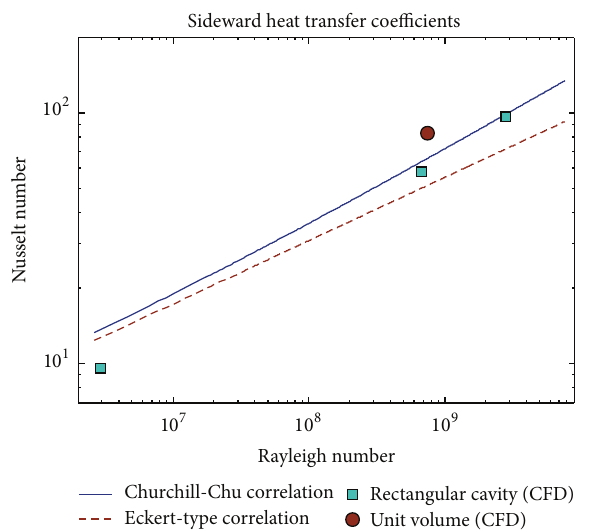
Figure5: Sideward heat transfercoefficients (mixed naturalconvec- tion).